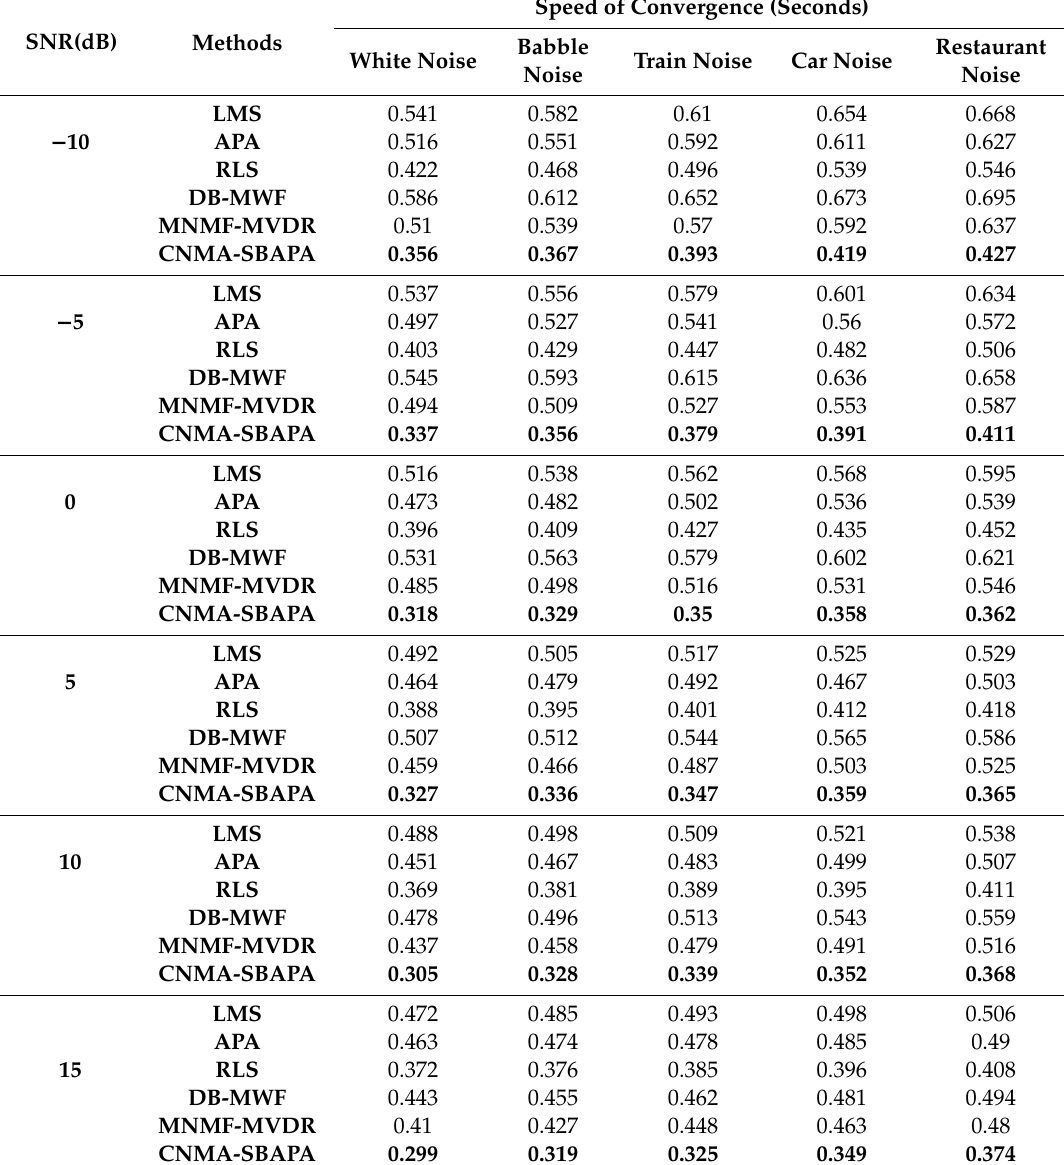
Table 6. The speed of convergence, in seconds, for the proposed CNMA-SBAPA in comparison with the LMS, traditional APA, RLS, DB-MWF, and MNMF-MVDR methods for white and colored noises on real data in di ff erent range of SNRs (the bold numbers are the best